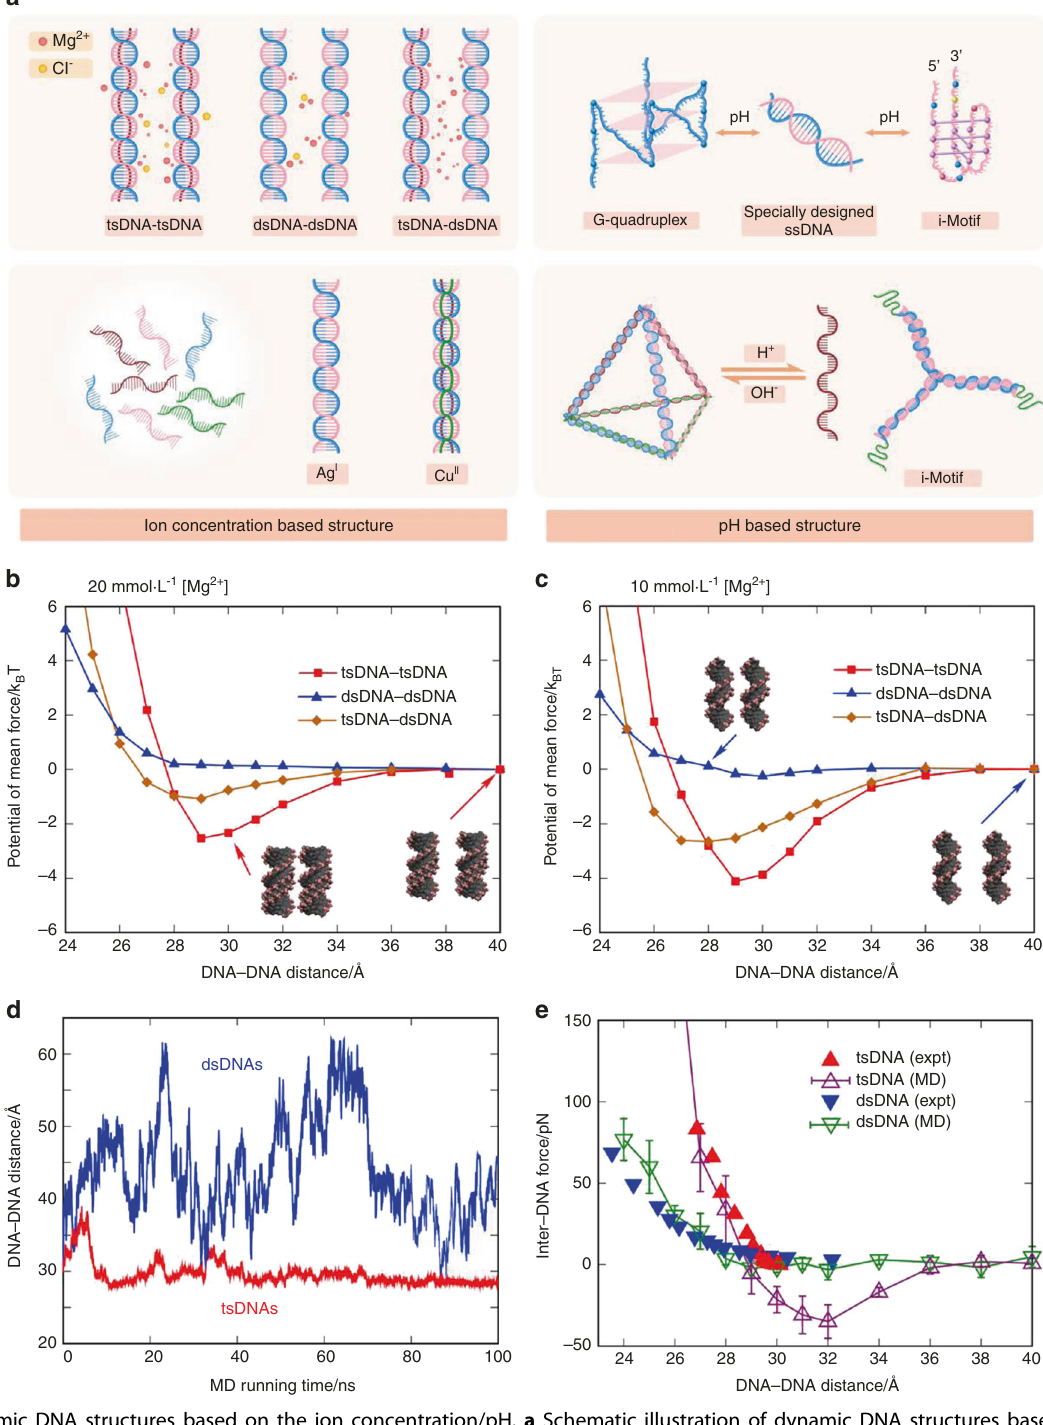
Fig. 2 Dynamic DNA structures based on the ion concentration/pH. a Schematic illustration of dynamic DNA structures based on the ion concentration or pH. The mean force potentials between DNAs are given for three cases, namely, tsDNA-tsDNA, dsDNA-dsDNA, and tsDNA- dsDNA, in ∼ 20 ( b ) and ∼ 100 mmol·L − 1 Mg 2 + solutions ( c ). d Shown here is the distance between the mass center of the DNAs versus the MD simulation time from MD simulations for two tsDNAs (red) and two dsDNAs (blue) without the connection spring in a 20 mmol·L − 1 Mg 2 + solution. e The inter-DNA forces were calculated from our MD simulations and the experimental measurements on osmotic pressure. 151 Copyright 2017, Biophysical